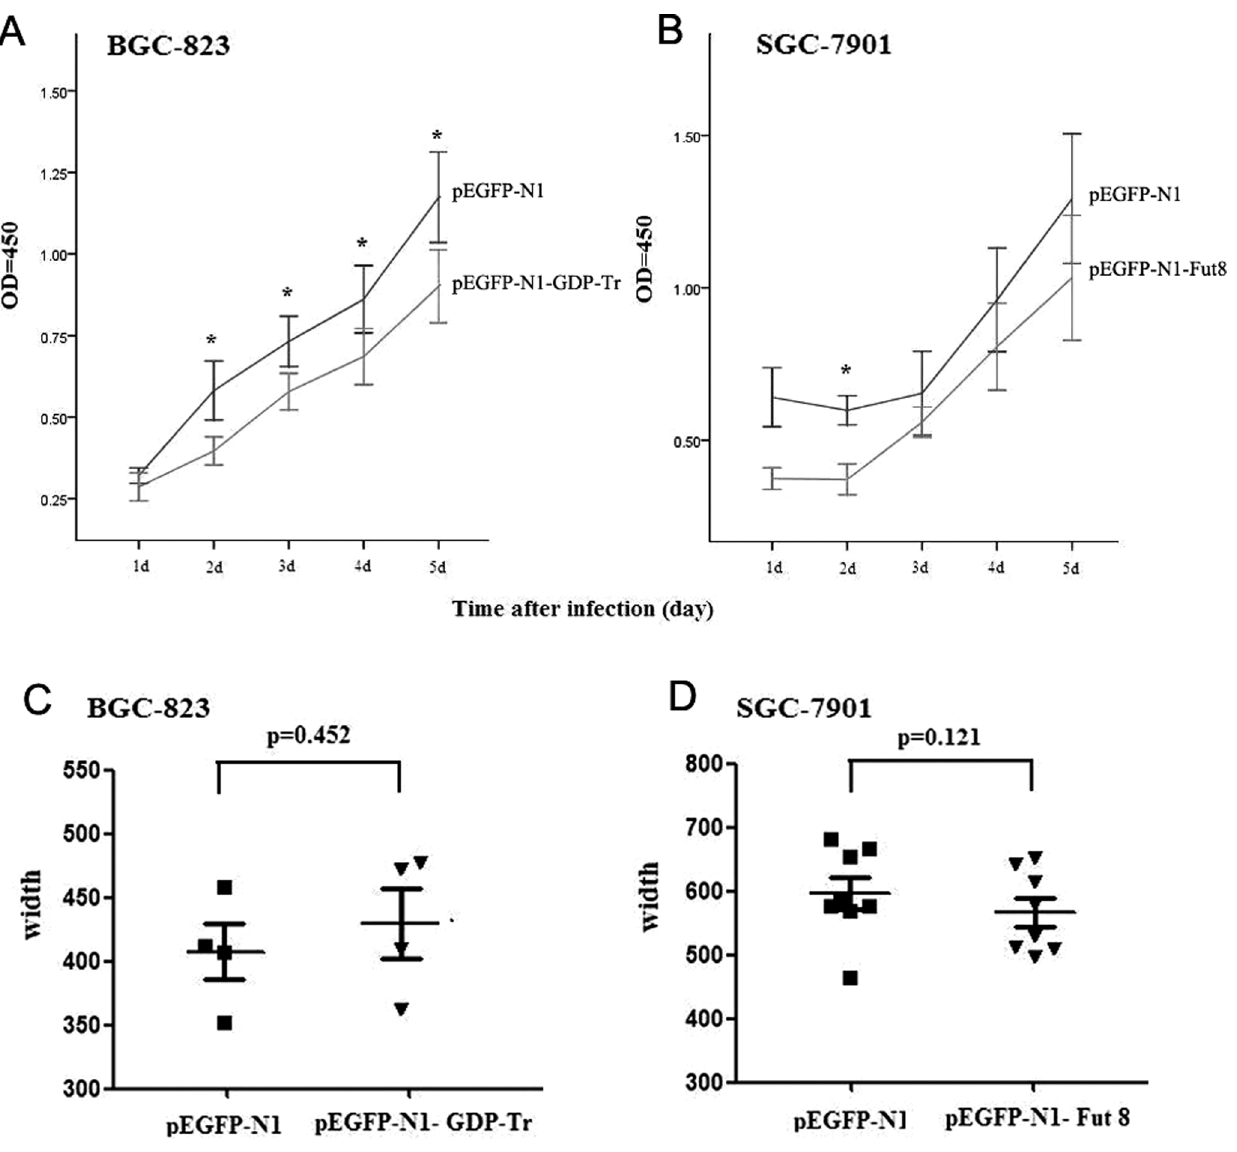
Figure 5. The proliferation and wound healing migration assay of gastric cancer cells transfected with recombinant expression plasmids. (A) and (B) The proliferation of BGC-823 cells and SGC-7901 cells after transfection with pEGFP-N1-GDP-Tr and pEGFP-N1-Fut8 respectively was analyzed by Cell Counting Kit-8 (CCK-8) assays. Representative results from four independent experiments are shown. * P , 0.05 compared with control group. (C) and (D) The wound healing migration assay of BGC-823 cells after transfection with pEGFP-N1-GDP-Tr as well as SGC-7901 cells after transfection with pEGFP-N1-Fut8. The gap distance ( m m) in migration assay can be quantitatively evaluated using softwares. Representative results from 3 independent experiments are shown. P . 0.05 compared with control